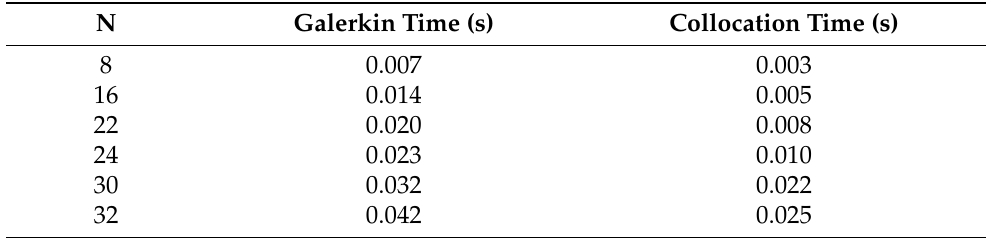
Table 2. The calculation times of the Chebyshev–Galerkin and Chebyshev–collocation methods vary with N